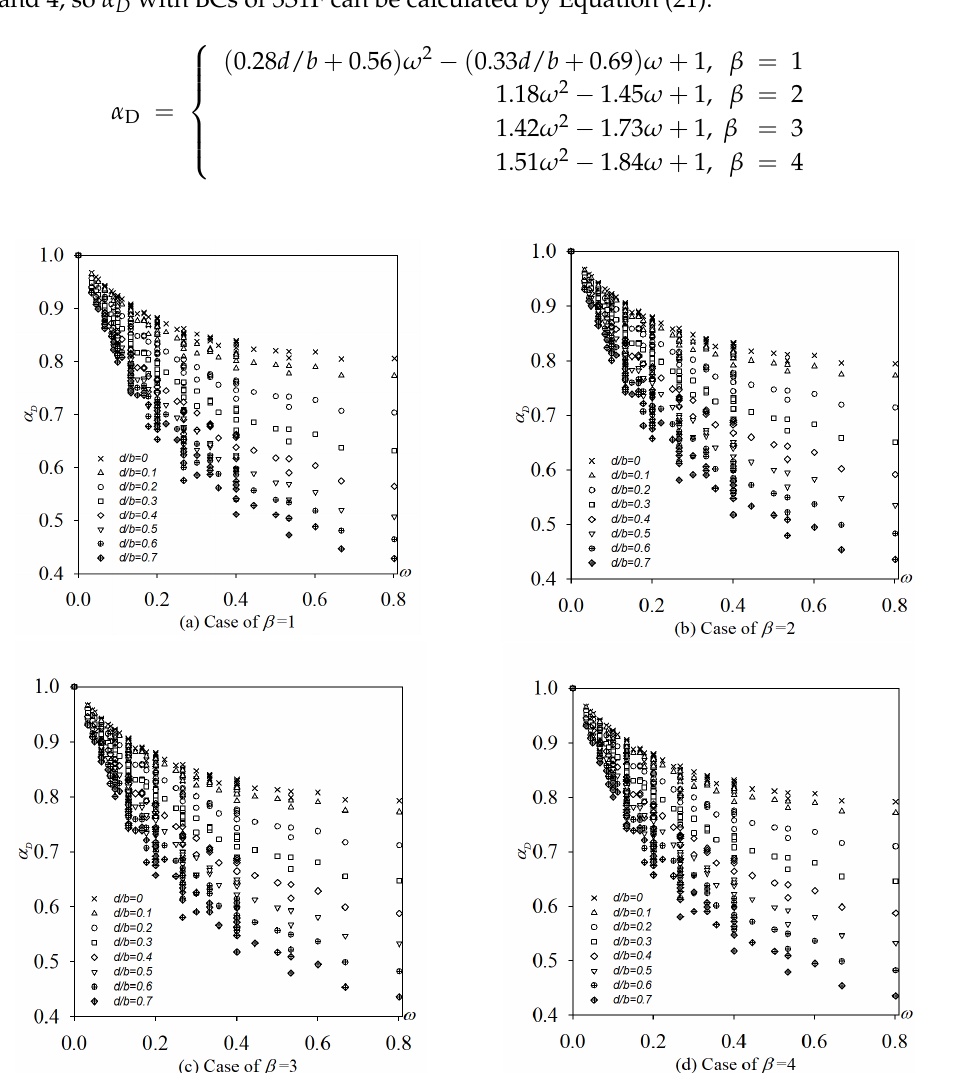
Figure 14. α D vs. ω for perforated rectangular plate ( β = 1, 2, 3, 4) with the BCs of 4S.